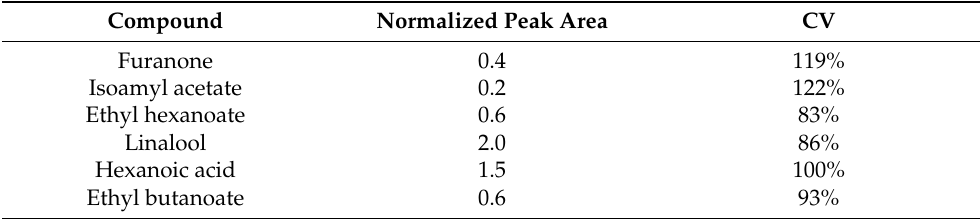
Table 2. Mean value of normalized peak area (cumulative sum of ion intensity/min retention time) and coefficient of variation (CV) of six volatiles measured in “Jewel” strawberry fruit collected in 2018 from 22 farms across New York State. Compound Normalized Peak Area CV Furanone 0.4 119% Isoamyl acetate 0.2 122% Ethyl hexanoate 0.6 83% Linalool 2.0 86% Hexanoic acid 1.5 100% Ethyl butanoate 0.6